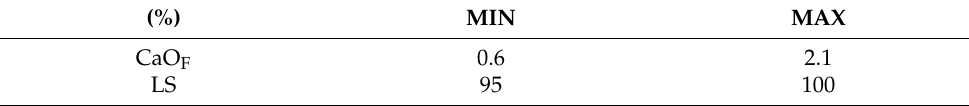
Table 3. Measured values—free lime content in clinker (CaO F